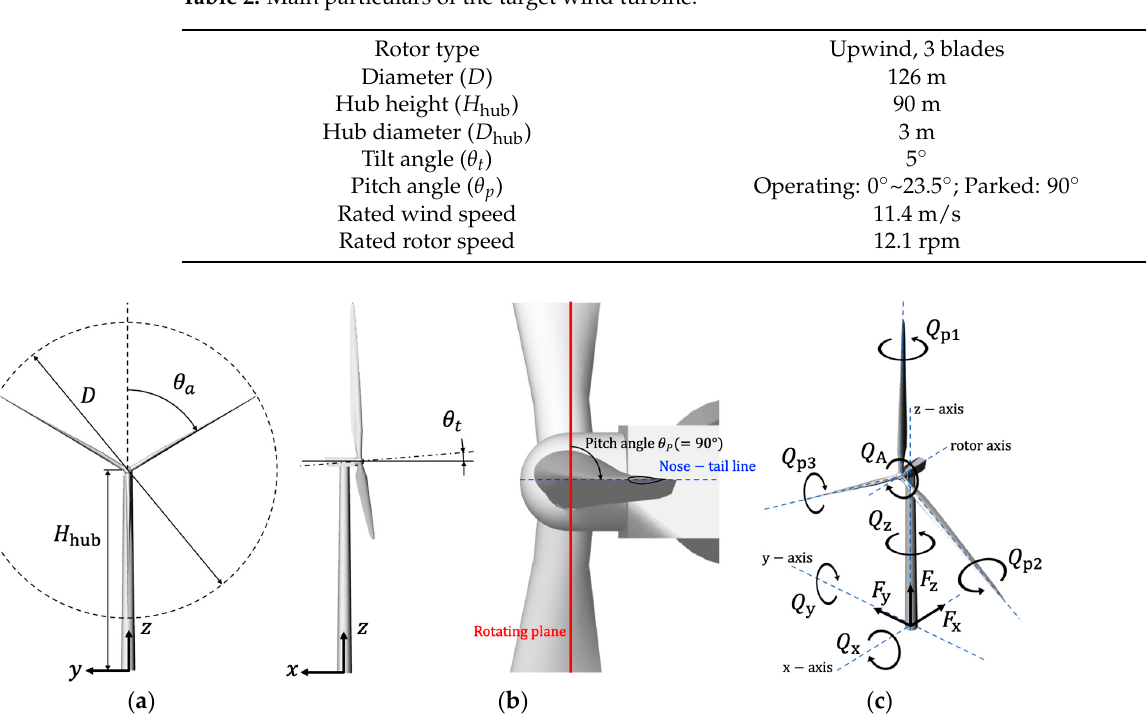
Figure 9. National Renewable Energy Laboratory (NREL) 5-MW wind turbine. ( a ) Tilt angle; ( b ) blade pitch angle; ( c ) aerodynamic loads.